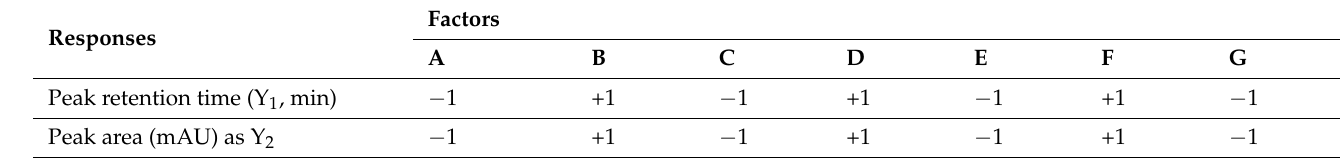
Table 1. Various critical attributes affecting ACV method development (screening).